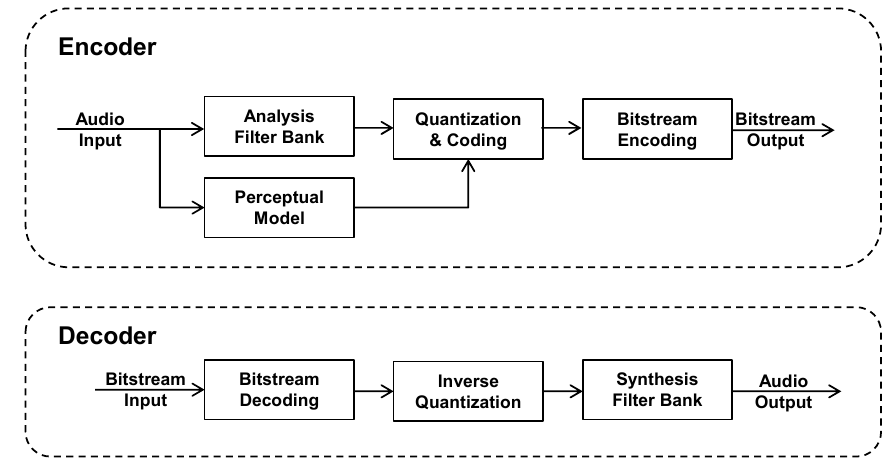
Figure 1. Schematic principle of perceptual audio encoding and decoding.